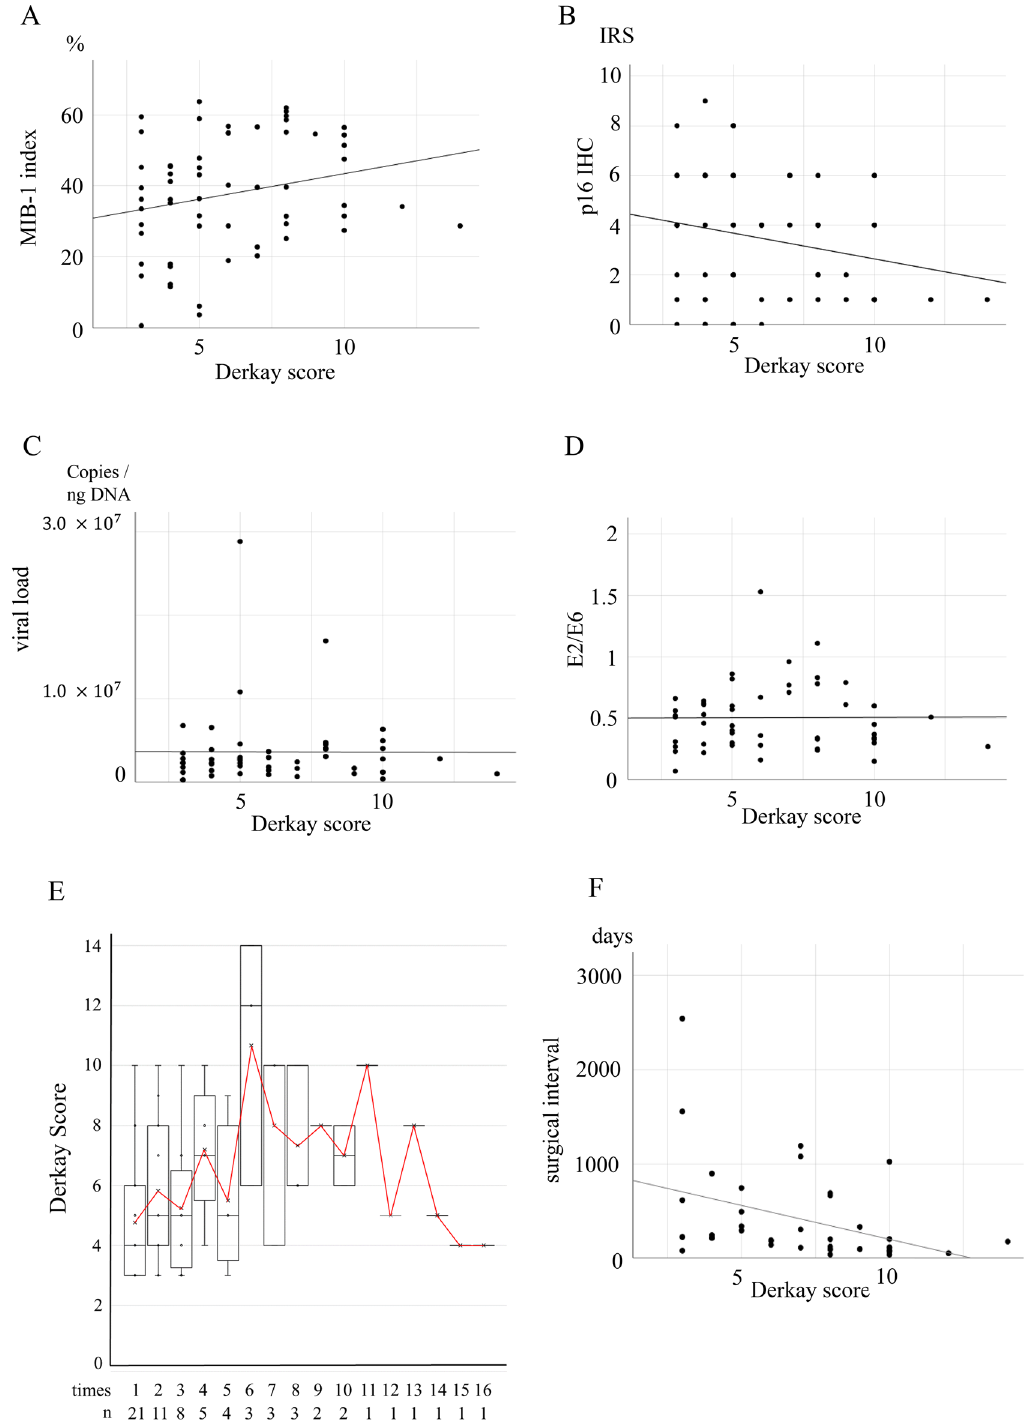
Figure 7. Scatter plots and regression lines for the Derkay score. ( A ) MIB-1 index and Derkay score show a weak positive correlation (r = 0.23, p = 0.07). ( B ) P16 IHC and Derkay scores show a weak negative correlation (r = − 0.23, p = 0.06). ( C ) Viral load and Derkay scores show no correlation (r = − 0.004, p = 0.976). ( D ) E2/E6 and Derkay scores show no correlation (r = 0.006, p = 0.966). ( E ) There is no significant trend in the mean change in the Derkay Score at each time of surgery. ( F ) Surgical interval and Derkay score show a negative correlation (r = − 0.40, p = 0.01). IHC Immunohistochemistry, DS Derkay